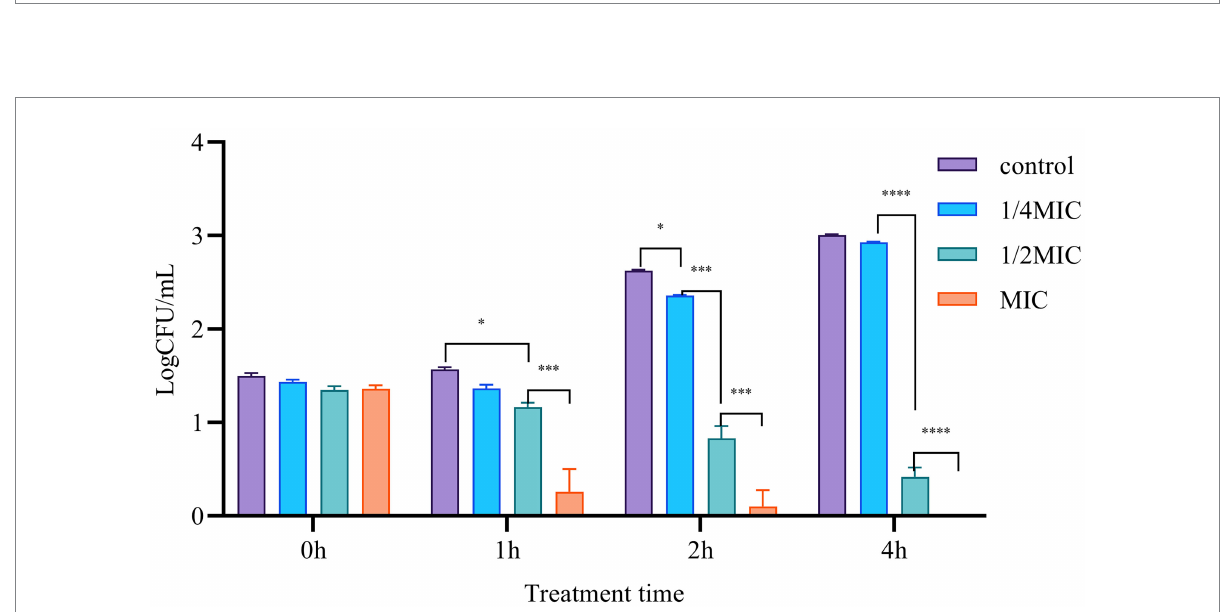
FIGURE 6 The time-killing results. Error bars represent standard deviation from the mean of three replicate values (ns non statistically significant difference, * p <0.05, ** p <0.01, *** p <0.001, **** p